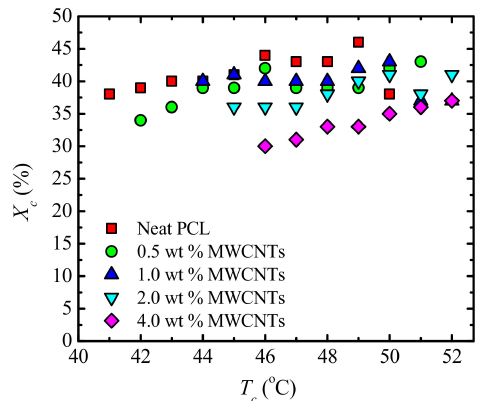
Figure 19. Relative crystallinity ( X c ) as a function of isothermal crystallization temperature ( T c ) for neat PCL and the PCL/(PC/MWCNT) nanocomposites.